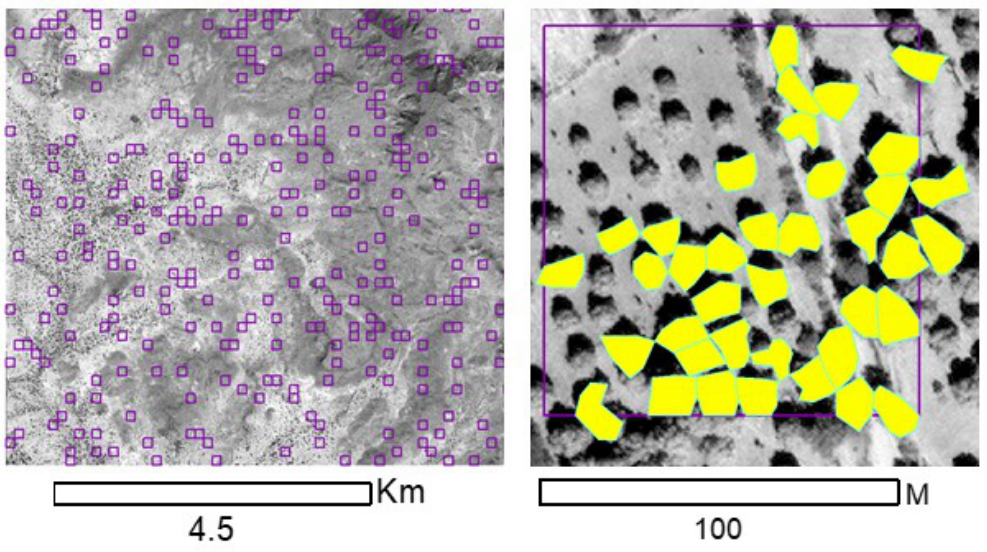
Figure 8. Example of sampling grid cells for Sakou ( left ) and example of digitized tree canopies within a sample grid cell for Sakou ( right ). Land 2020 , 9 , 208